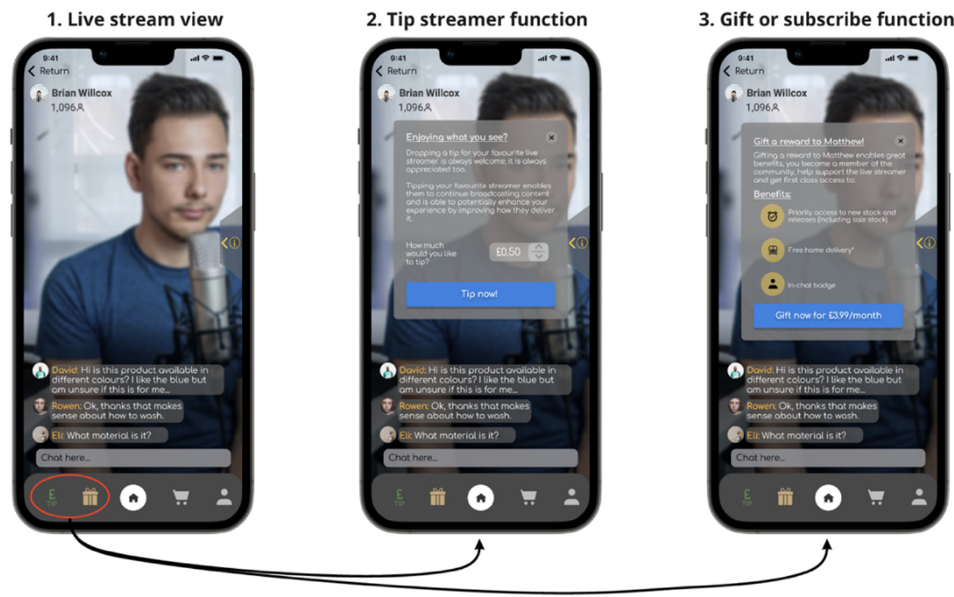
Figure 16. A high-fidelity mock-up of a live stream commerce ‘plug-in’ generated from the Participa- tory and Co-design workshops, demonstrating various in-chat functions, in